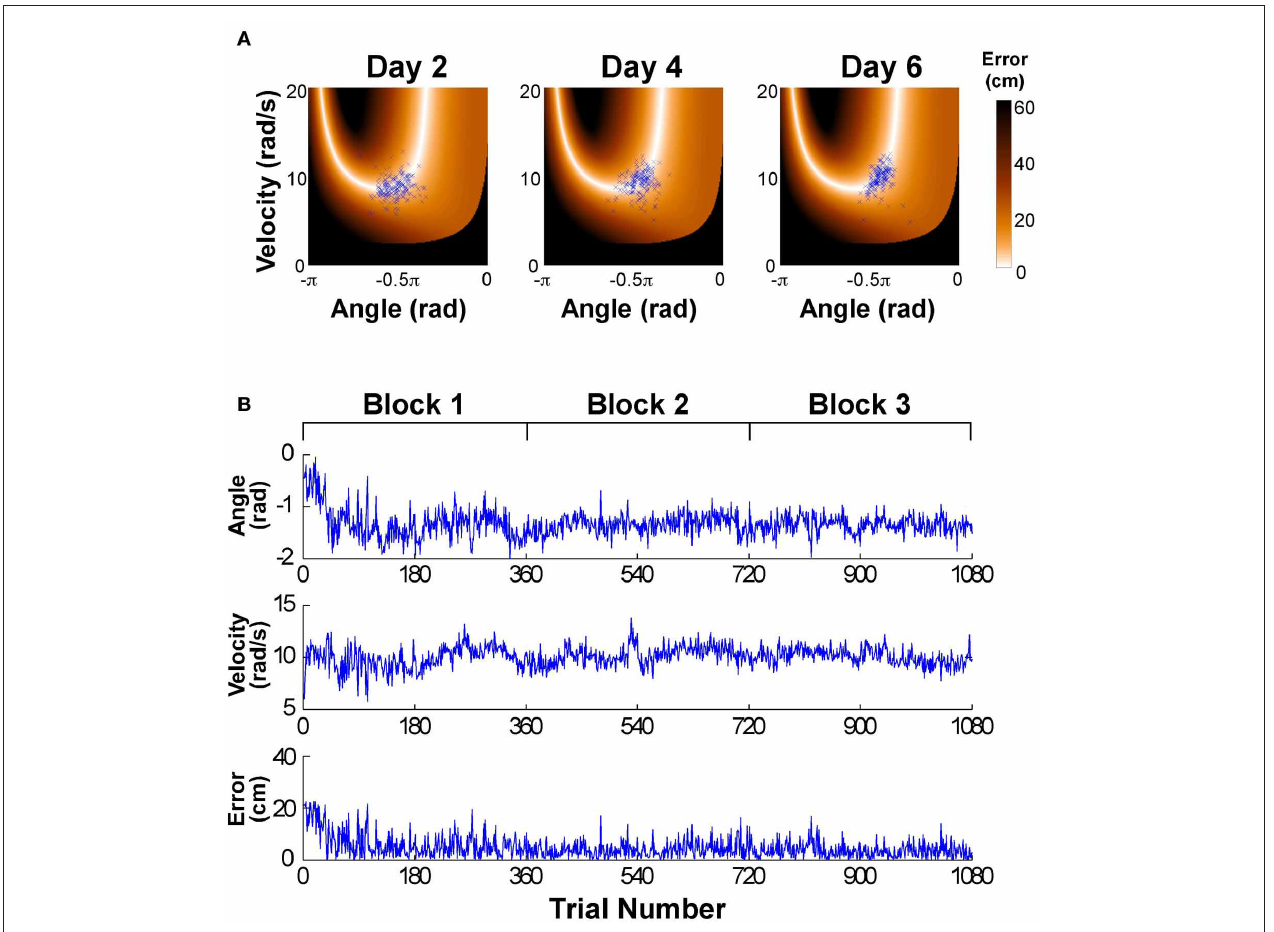
FIGURE 2 | (A) Data of one participant represented in execution space. The horizontal and vertical axis shows position and velocity, respectively, and the color encodes the error. The data distribution changes across days by